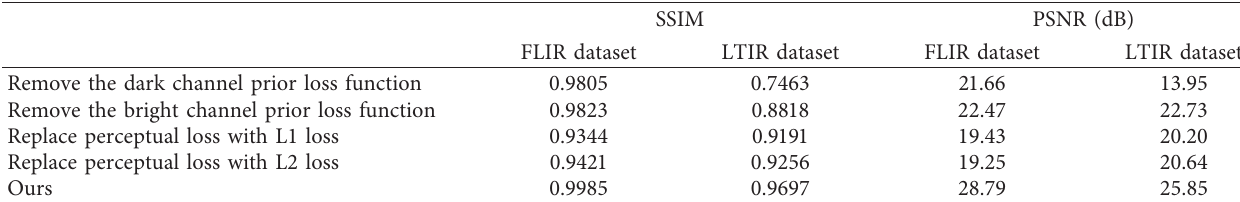
Table 6: Ablation study of the channel prior loss